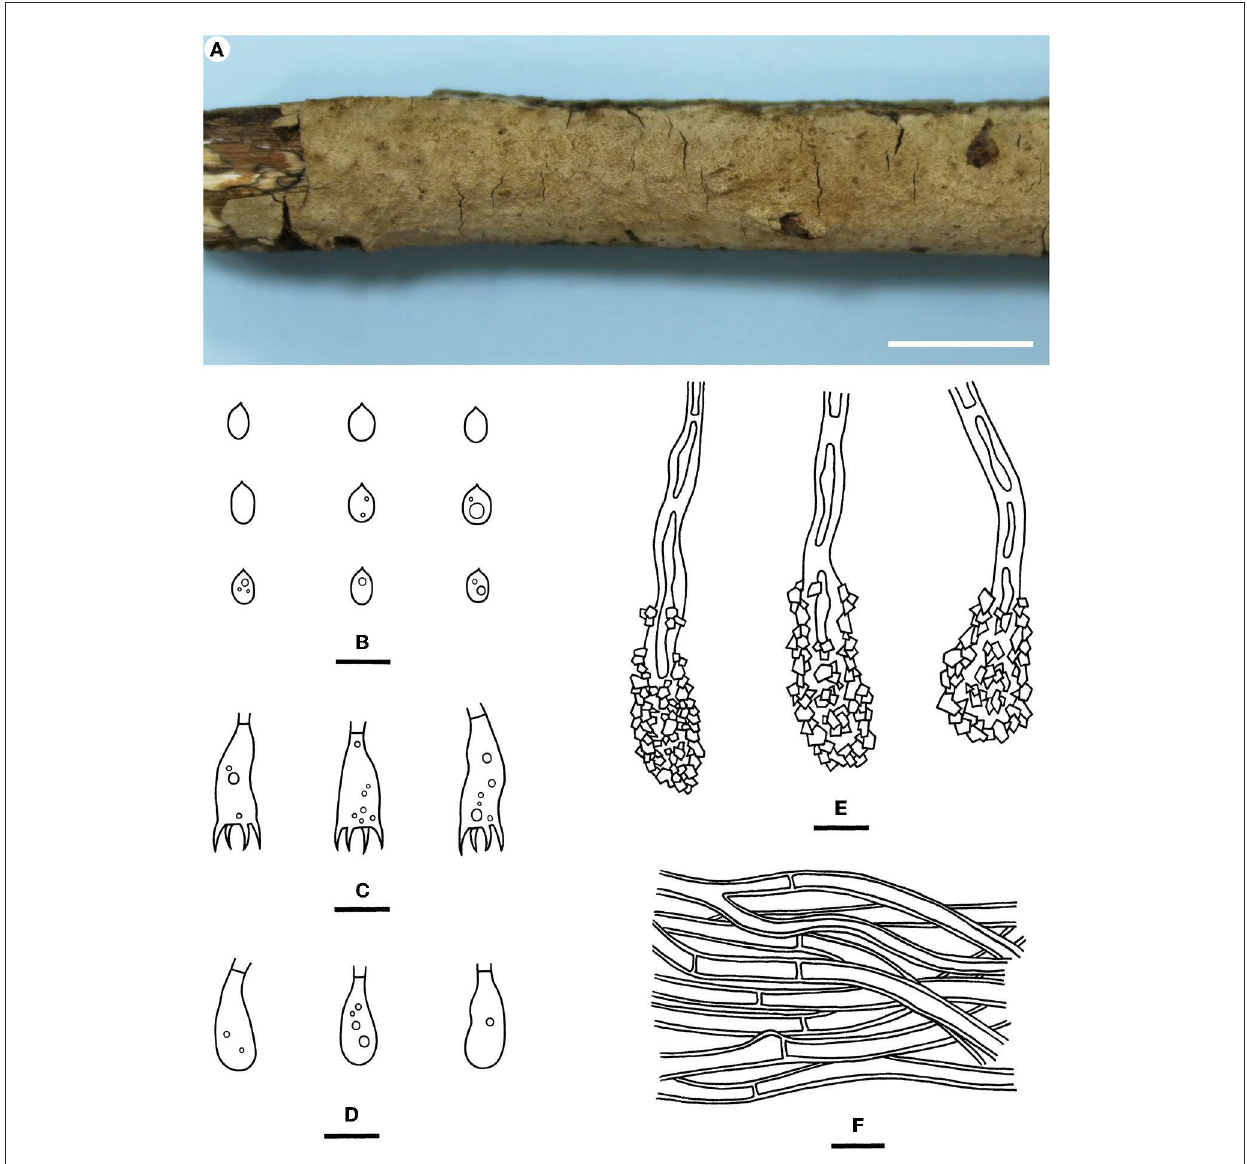
FIGURE6 Hyphodermella tropica [from the holotype He 3933; scale bars: (A) = 1cm; (B–F) = 10 µ m]. (A) Basidiomes; (B) Basidiospores; (C) Basidia; (D) Basidioles; (E) Encrusted cystidioid hyphal ends; (F) Hyphae from subiculum.